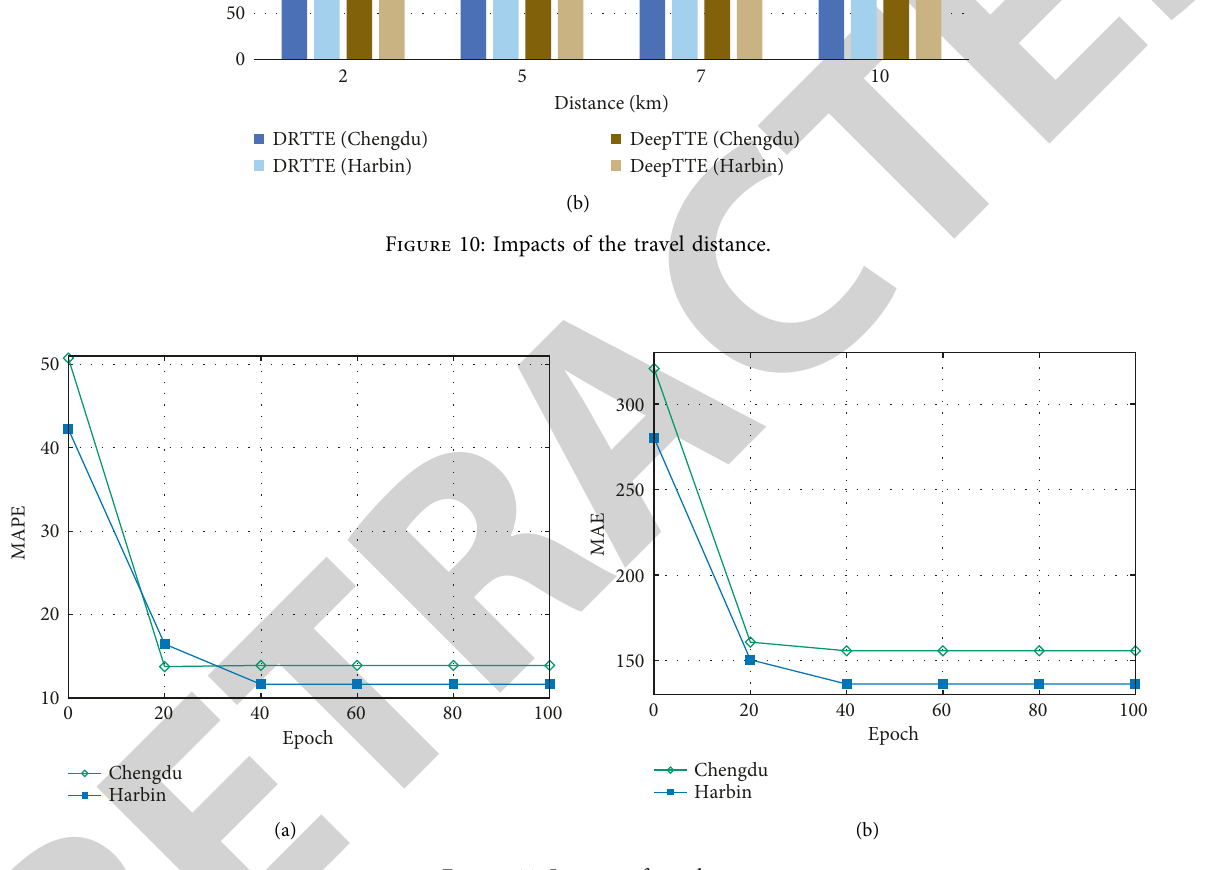
Figure 11: Impacts of epoch.